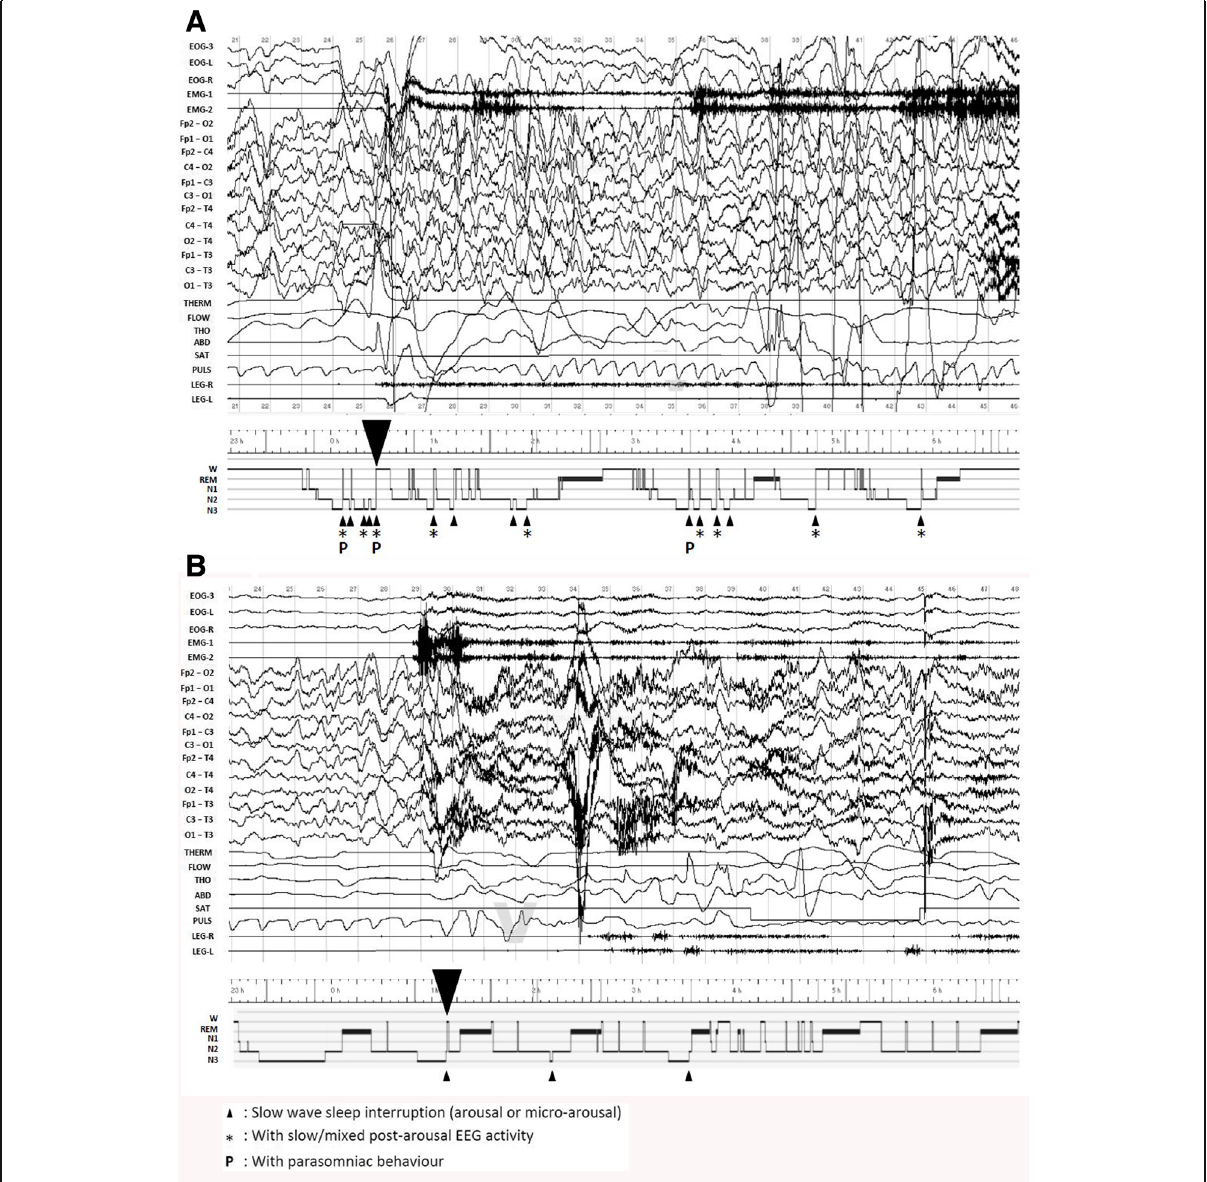
Fig. 1 Polysomnographic characteristics of a patient with Disorders of Arousal (DOA) and a healthy adult. a : The hypnogram shows an excessive amount of Slow Wave Sleep (SWS) interruptions, frequently characterized by slow/mixed post-arousal EEG activity. Three SWS interruptions are accompanied by complex behavioral manifestations defining parasomniac episodes (lower panel). During such interruption, the polysomnography reveals slow or mixed sleep-wake features, with motor and autonomic activations (upper panel). b : By contrast, SWS continuity is preserved in healthy subjects with rare interruptions (lower panel). The polysomnography reveals a fast post-arousal EEG activity during SWS interruption (upper